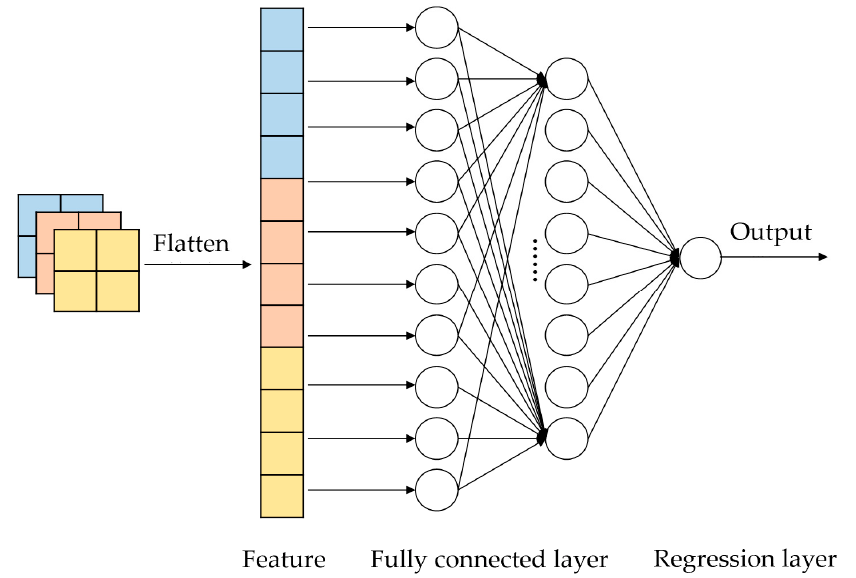
Figure 4. The fully connected layer .